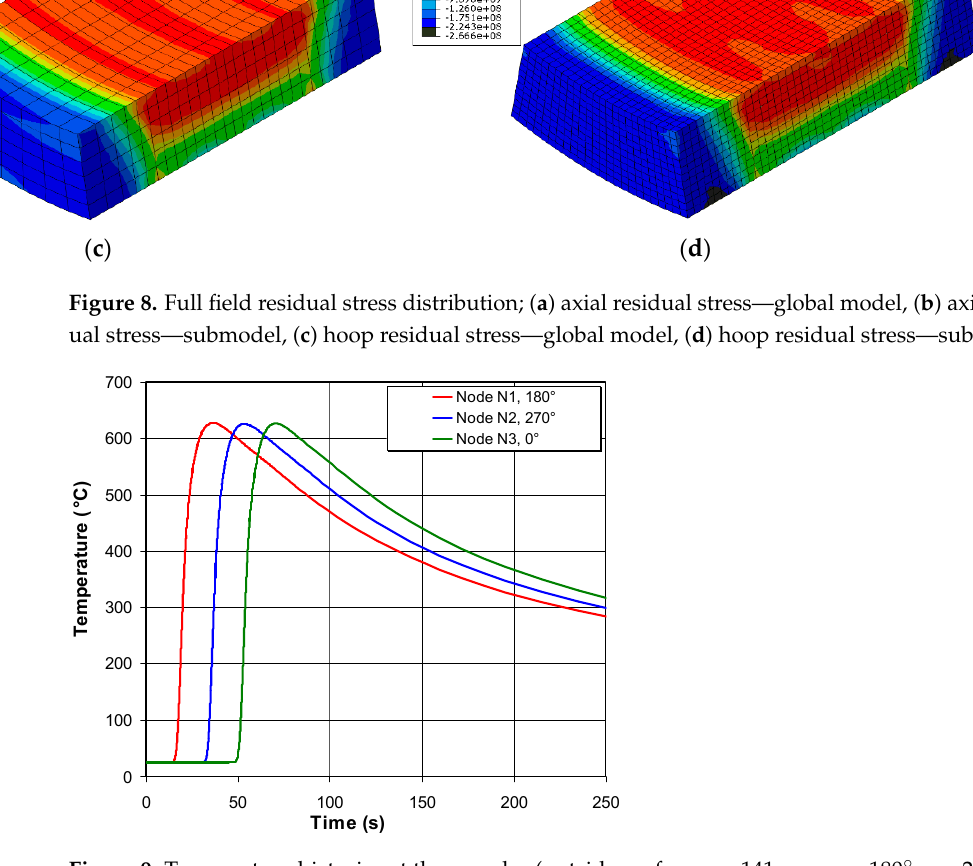
Figure 9. Temperature histories at three nodes (outside surface, z = 141 mm, α = 180°, α = 270° and α = 0°).